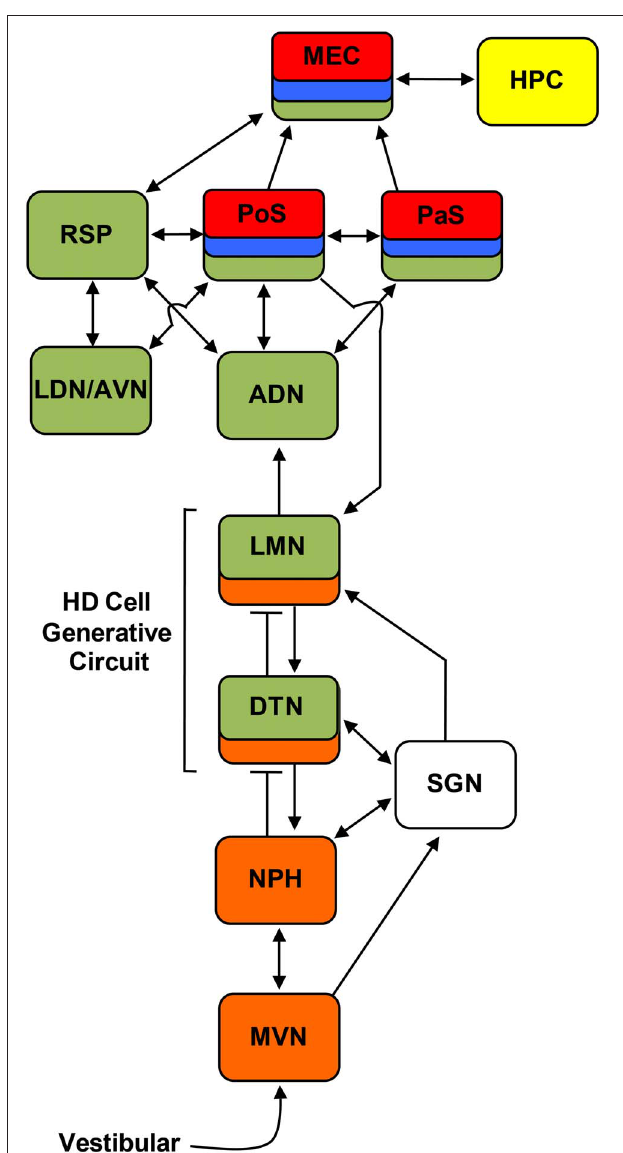
FIGURE 2 | Circuit diagram showing the principle connections between brain regions containing place cells (yellow), grid cells (red), border cells (blue), HD cells (green), and angular velocity cells (orange) (Sharp et al., 2001a; Taube and Bassett, 2003; Taube, 2007). Arrows indicate excitatory projections, and lines that end with a bar represent inhibitory projections. ADN, anterodorsal thalamus; AVN, anteroventral thalamus; DTN, dorsal tegmental nucleus; HPC, hippocampus; LDN, laterodorsal thalamus; LMN, lateral mammillary nuclei; MEC, medial entorhinal cortex; MVN, medial vestibular nuclei; NPH, nucleus prepositus hypoglossi; PaS, parasubiculum; PoS, postsubiculum; RSP, retrosplenial cortex; SGN, supragenual